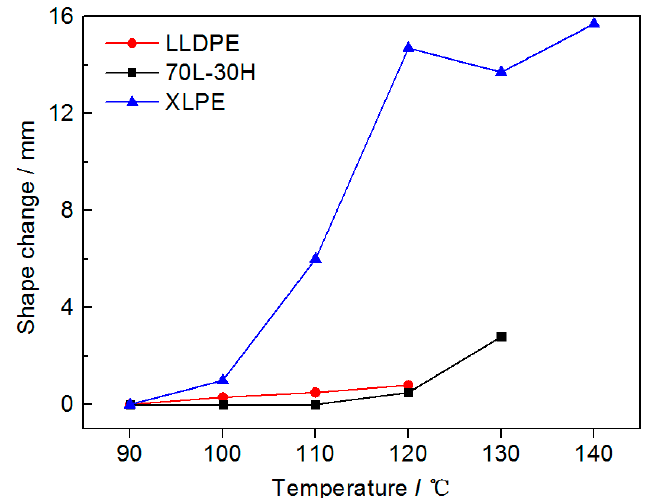
Figure 4. Test results of hot set tests with temperature.